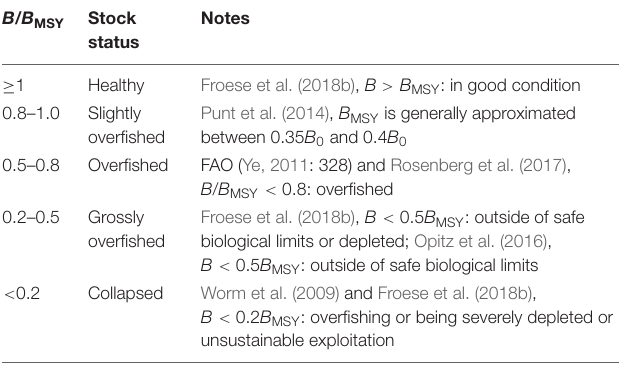
TABLE 3 | Definition of fish stock status, based on B / B MSY